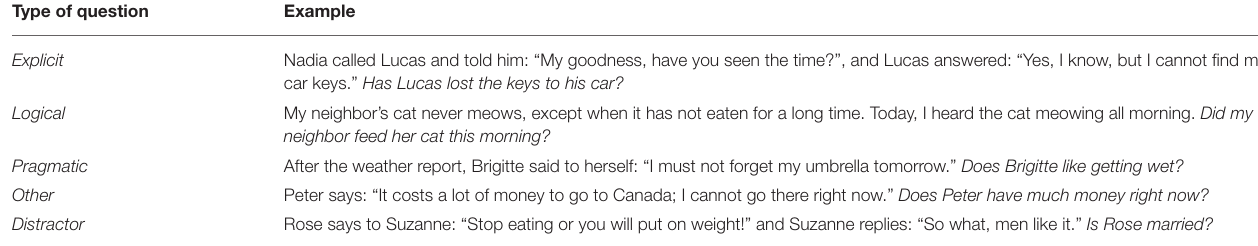
TABLE 1 | Types of questions in the implicit management test. Type of question Example